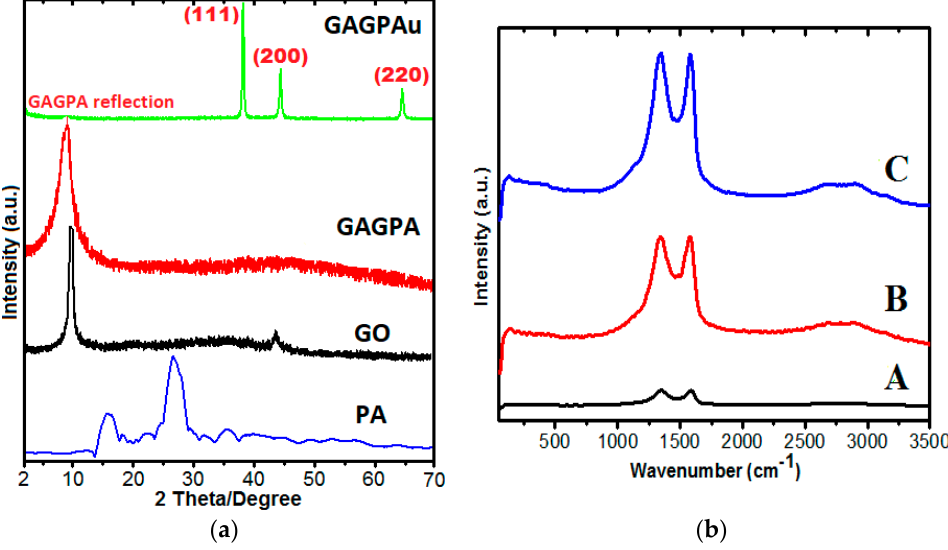
Figure 2. ( a ) PXRD diffractograms of the pure protocatechuic acid, GO nanosheets, protocatechuic acid loaded on GO/Gd nanolayers (GAGPA) and gold nanoparticles coated on